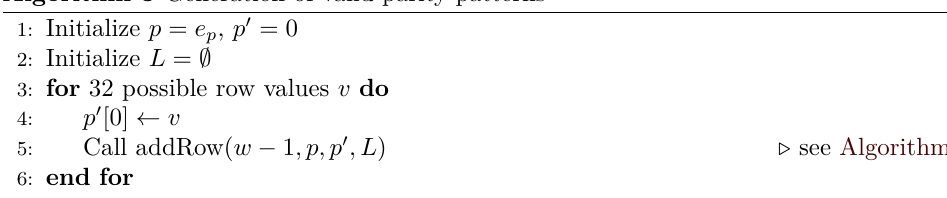
Algorithm 3 Generation of valid parity